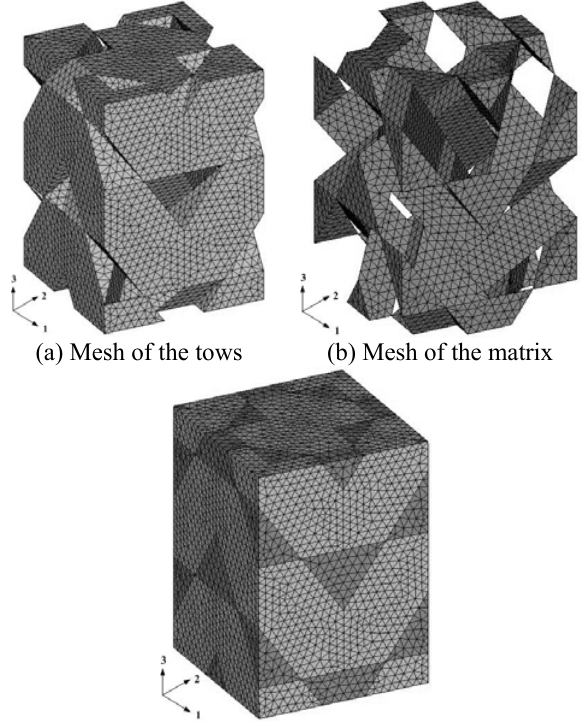
Fig. 12. Finite element model of the tow-scale RVC